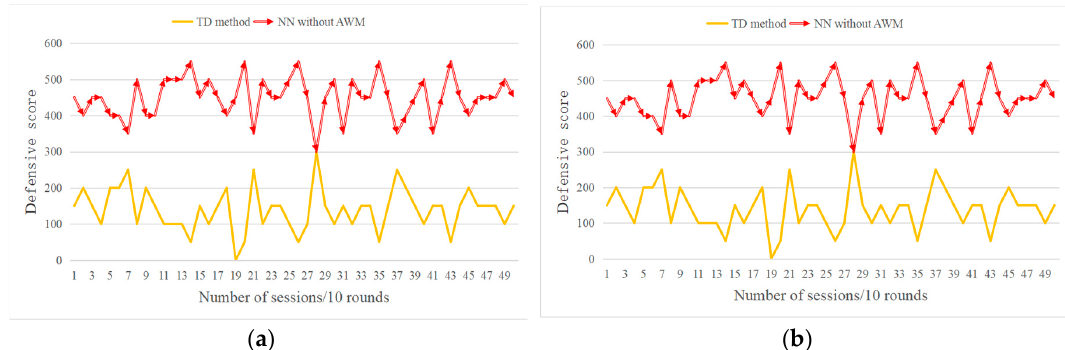
Figure 11. The curve of the fluctuation value of the total score ratio.